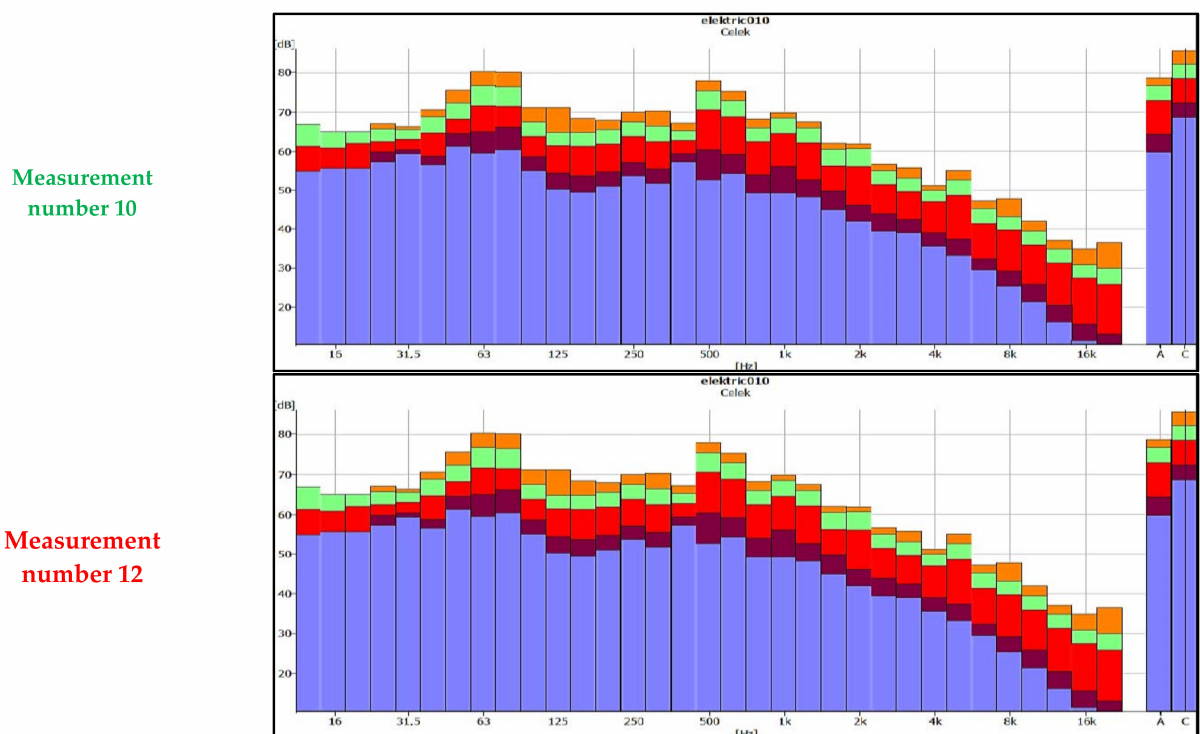
Figure 7. Frequency spectrum of values of noise levels of selected measurements (from above LZF max